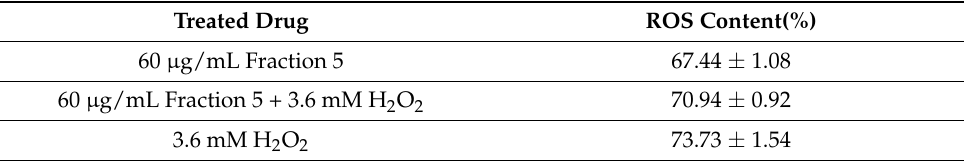
Table 4. The ROS content of different treatments.